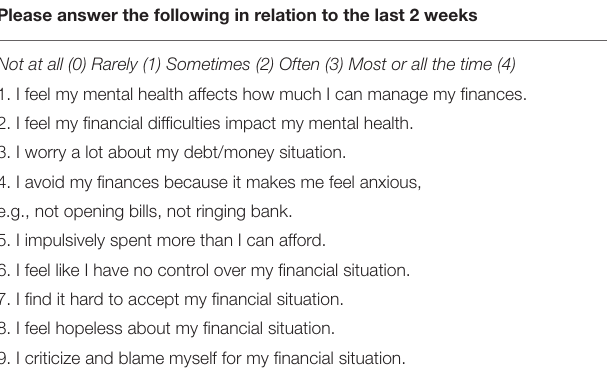
TABLE 3 | Questions from the money and mental health